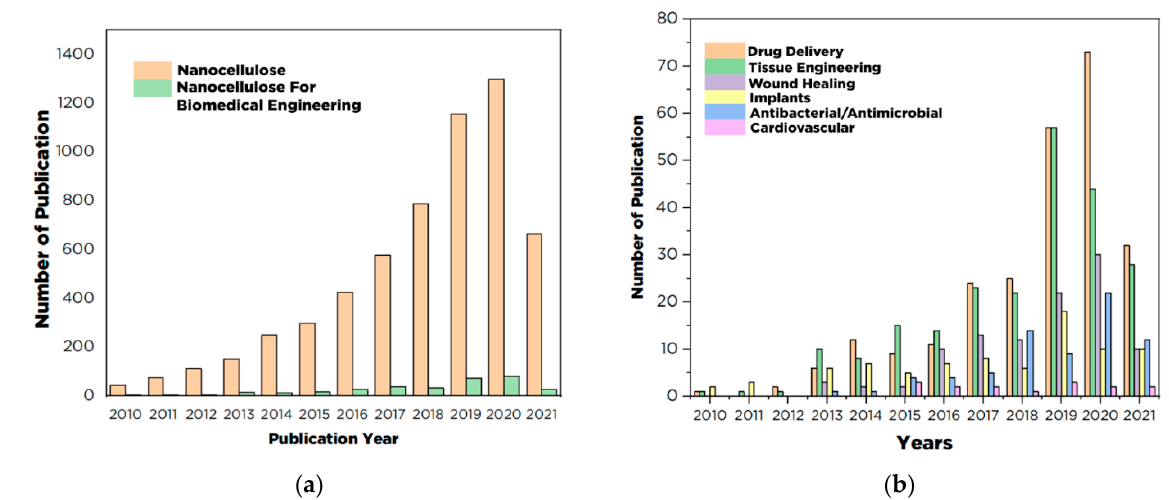
Figure 1. The number of publications in the area of nanocellulose and nanocellulose for biomedical engineering indexed by Scopus from 2010-until recent (10 June 2021) ( a ); data representation of annual publication of nanocellulose in various categories of biomedical engineering within the last decades ( b ); data analysis performed on Scopus using the terms nanocellulose and nanocellulose for “x” (x refer to biomedical engineering, drug delivery, tissue engineering, wound healing, implants, Antibacterial/antimicrobial, and cardiovascular).